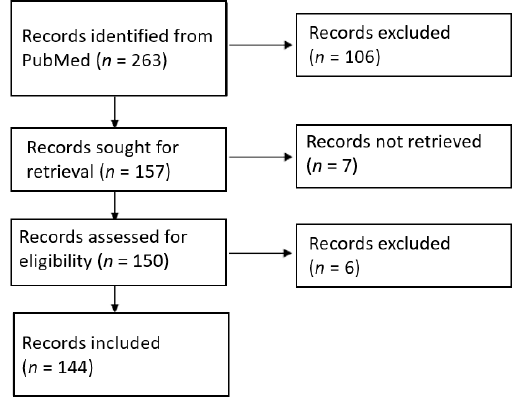
Figure 1. PRISMA flow chart.